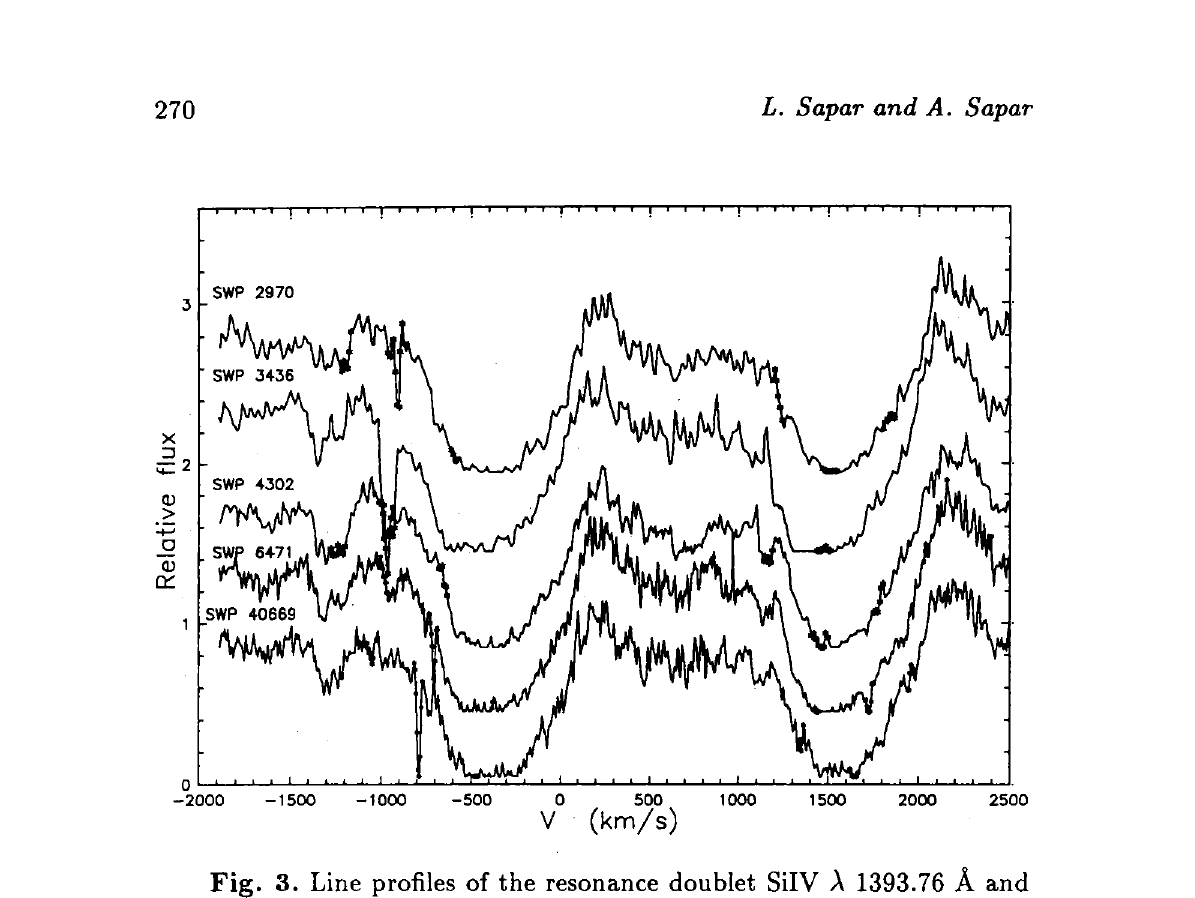
Fig. 3. Line profiles of the resonance doublet SilV A 1393.76 A and A 1402.77 A. The line profiles are free of strong blending lines. However, the moderate variations are seen in the width and in the blue slope of the resonance line components as well as in the blend profiles at 1388 A. Dif- ferently from the A1III resonance lines, the red wing emission component is much weaker. This shows that the resonance doublet of SilV originates from lower atmospheric layers than the resonance doublet of